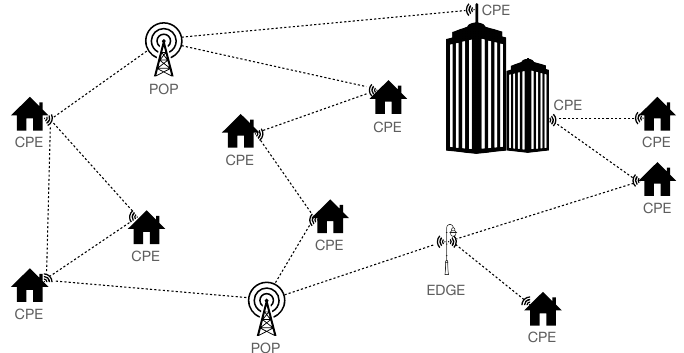
Figure 1. Fixed wireless access (FWA) system overview, with customer premises equipment ( CPE ) devices mounted on building facades forming a wireless mesh network. The mesh network is enabled by EDGE devices and the point of presence ( POP ) devices that form the interface to the wired internet